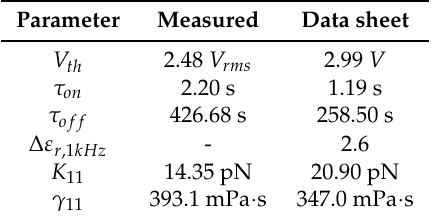
Figure 11. Permittivity and loss tangent of the liquid crystal at different bias voltages. Table 1. Threshold voltage and response times with their related